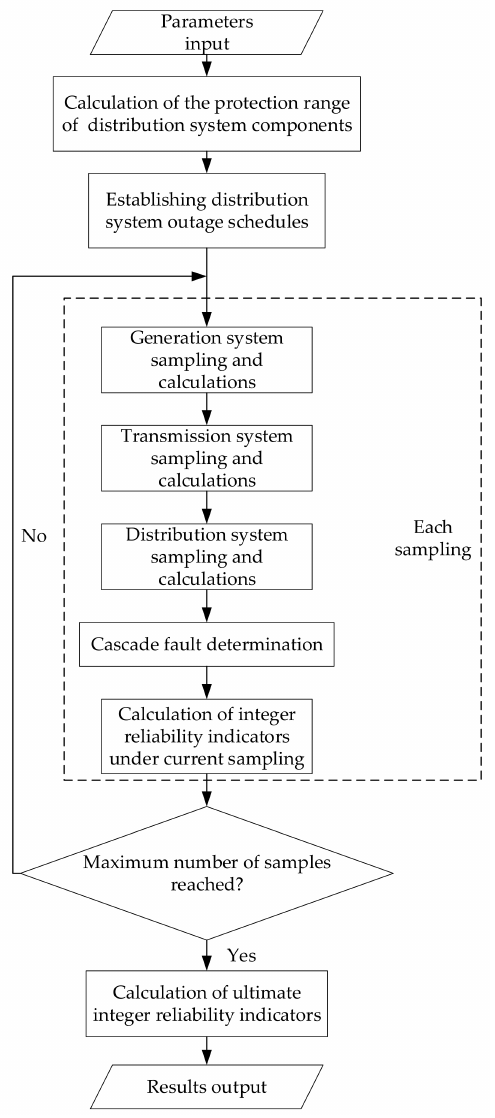
Figure 2. Reliability assessment